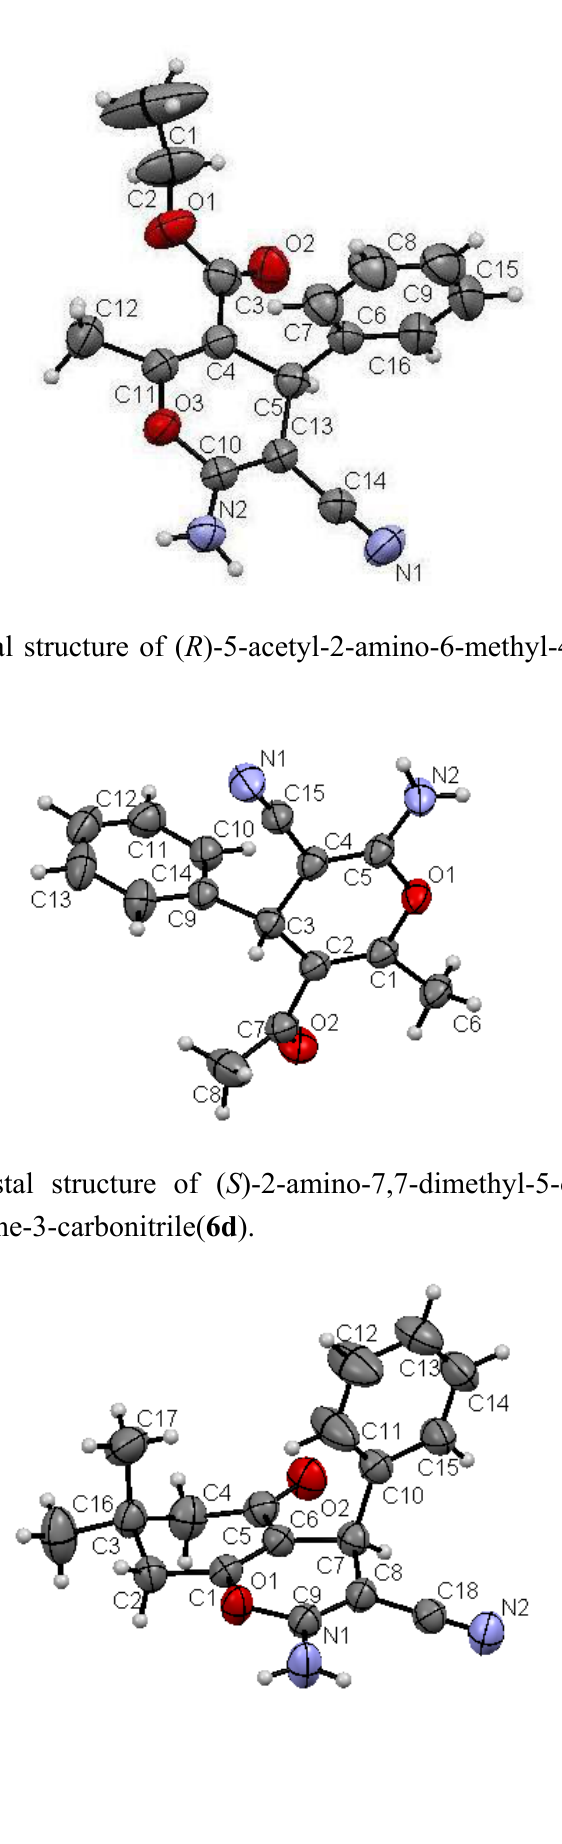
Figure 1. X-ray crystal structure of ( S )-ethyl 5-cyano-2,6-dimethyl-4-phenyl-4 H -pyran-3- carboxylate ( 6a ).